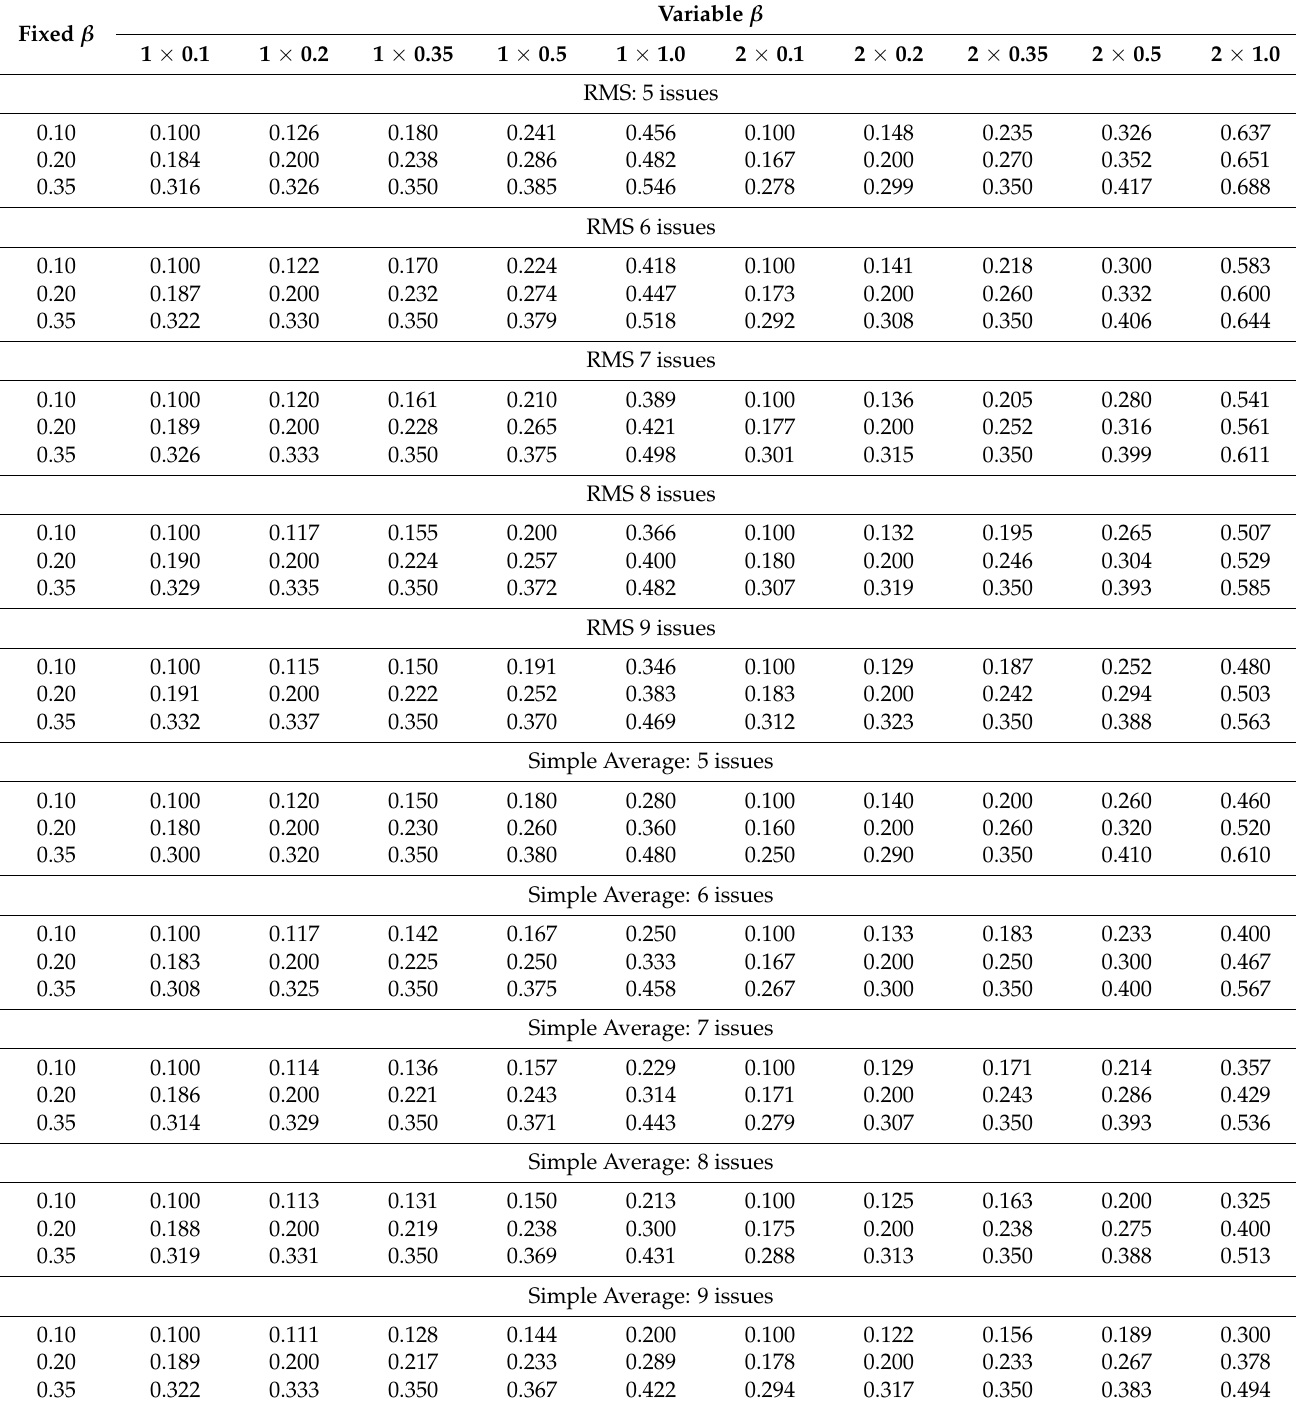
Table 4. Impact on the Building β of having all but indicated β i values fixed at the same value, with one (1 × ) or two (2 × ) β i values set at the variable β value. Two aggregation approaches are used: RMS of the β i Equation (2), and simple average. Appropriate linguistic ratings can be assigned using Table